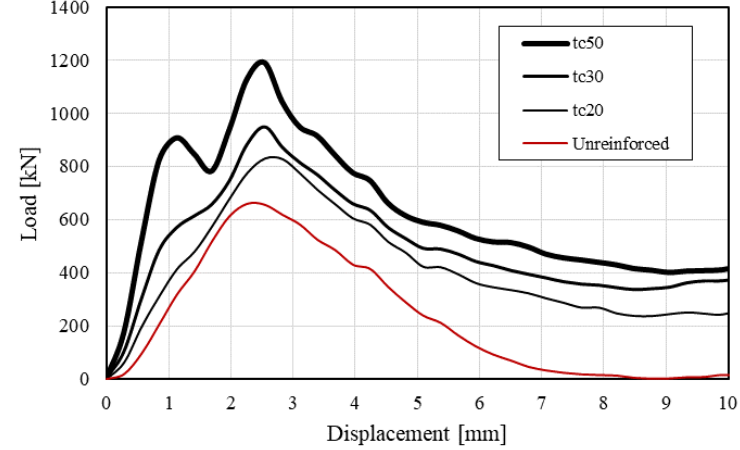
Figure 29. Load–displacement curves for different plaster thicknesses.